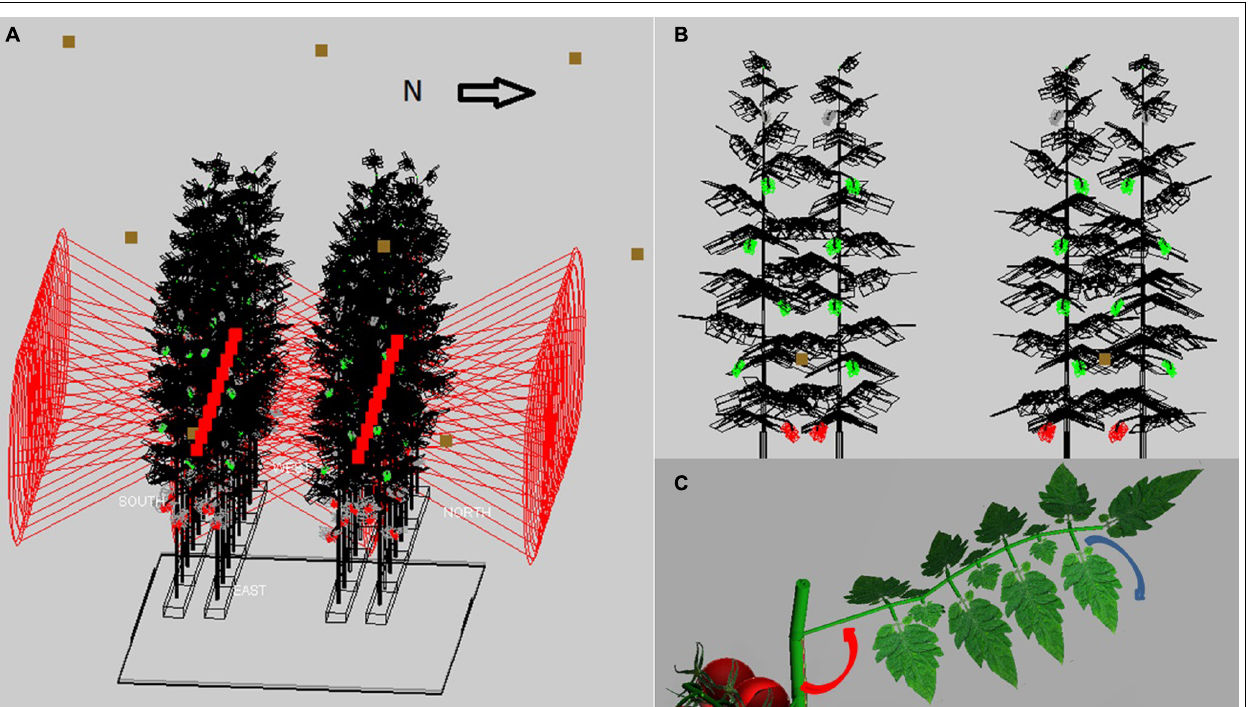
of four plants with leaf angles increasing with height (LED position at brown square), (C) rendered image of a single leaf with its rachis at a specific angle (red arrow) with the main stem, and consisting of leaflets that hang down by 30 − 50 ◦ (see blue arrow) relative to the